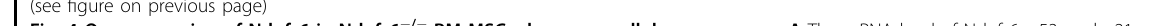
of MSC ageing, but also accelerates MSC ageing, thus